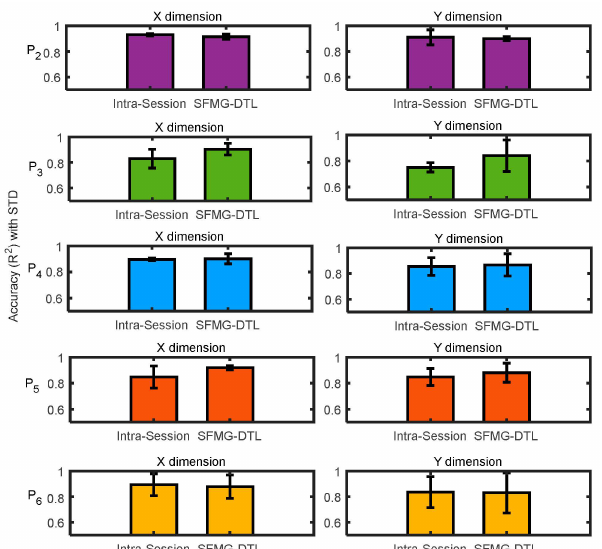
Figure 9. Comparing SFMG-DTL model with intra-session evaluation on case ii: target dataset 2 model in estimating forces in X and Y dimensions in domain